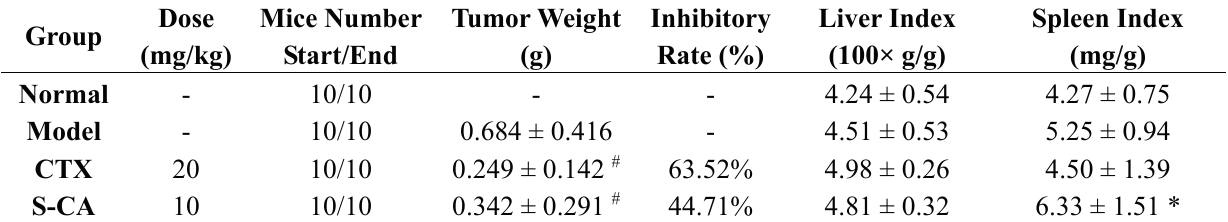
Table 4. Antitumor Effects of S-CA in S180 Mice (Mean ± S.D.).